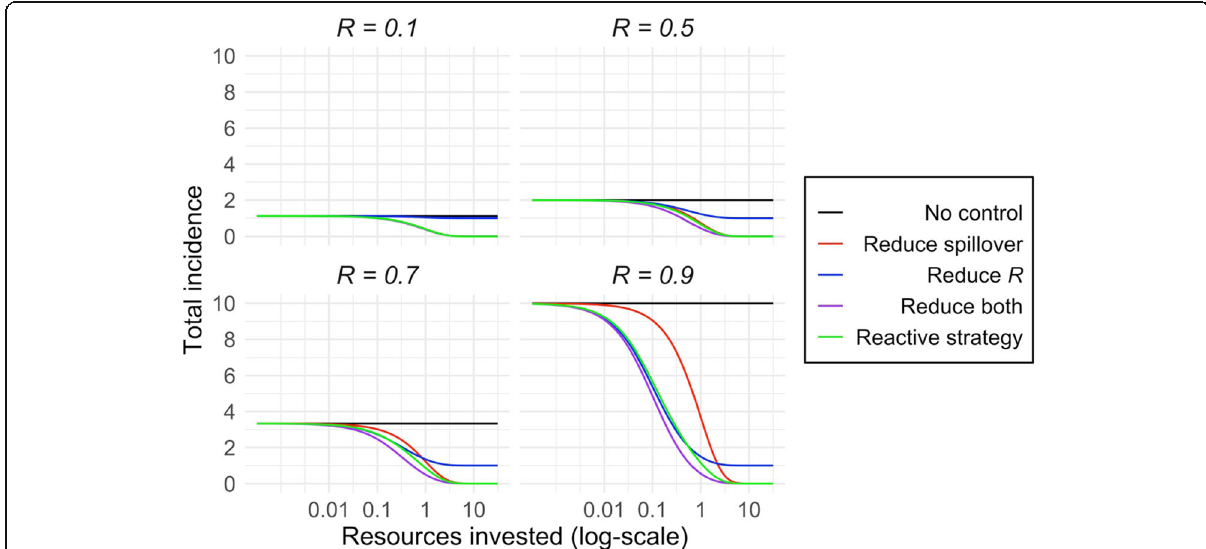
Fig. 4 Impacts of control measures with varying resource investments on incidence of a zoonotic infection with R between 0 and 1. Each panel shows a different R (before control) value. The black lines show the incidence under no control. Colored lines show the change in total incidence that would result from increasing investment for interventions that cause reductions in spillover transmission (red), human-to-human transmission (blue), or both types of transmission (purple). The green line shows the incidence for increasing investment resulting from a reactive intervention strategy, where effort is focused on reducing spillover transmission but is shifted to reducing human-to-human transmission once an outbreak is detected (Detection after two generations of transmission is shown). Controls measures targeting spillover transmission are assumed to be equally costly as measures targeting human-to-human transmission, i.e. α = 1 implement spillover reduction or human-to-human level of resources available, which we quantify here by transmission reduction (i.e. α = 1). This line corresponds the proportional reduction in spillover that is achievable to Eq. 7 for R switch , plotted parametrically as a function if all resources are devoted to spillover control (Fig. 5). The curved solid line marks the boundary between opti- of resource investment (i.e. with zero investment and c c mal strategies, assuming it is equally expensive to z = 1 at the bottom, and infinite investment and z = 0 at